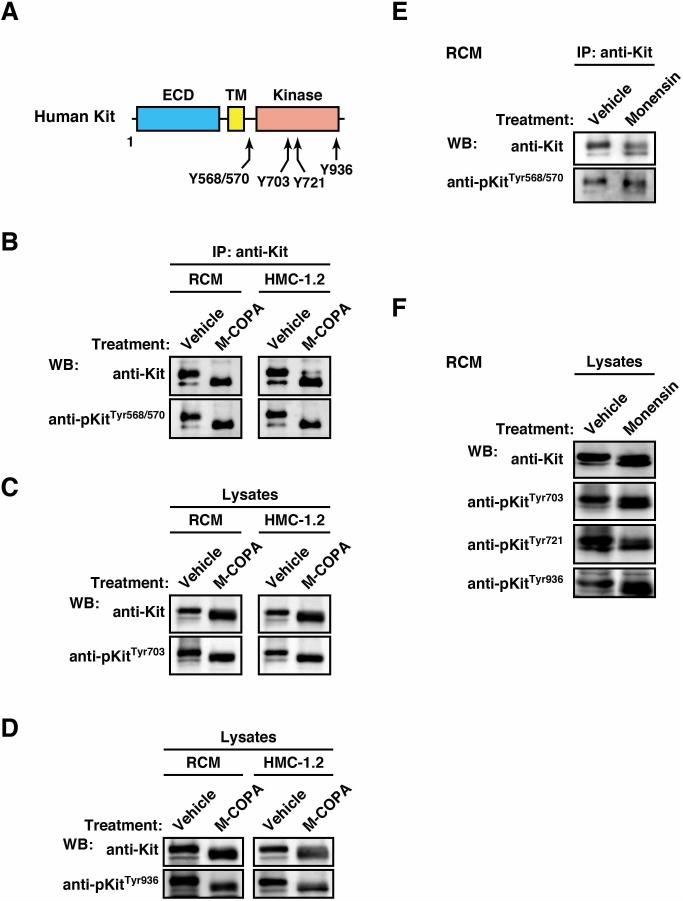
In neoplastic mast cells, Kit phosphorylation at Tyr568/570, Tyr703, Tyr721, and Tyr936 occurs on the ER.(A) Tyrosine phosphorylation sites in human Kit. (B-F) Cells were treated with vehicle or (B-D) 5 μM M-COPA for 16 hours or (E and F) 250 nM monensin for 24 hours. Anti-Kit immunoprecipitates (B and E) and cell lysates (C, D, and F) were immunoblotted with anti-Kit, anti-phospho-KitTyr568/570 (anti-pKitTyr568/570), anti-pKitTyr703, anti-pKitTyr721, and anti-pKitTyr936. Note that ER-localized Kit was phosphorylated at Tyr568/570, Tyr703, Tyr721 and Tyr936 in neoplastic mast cells.